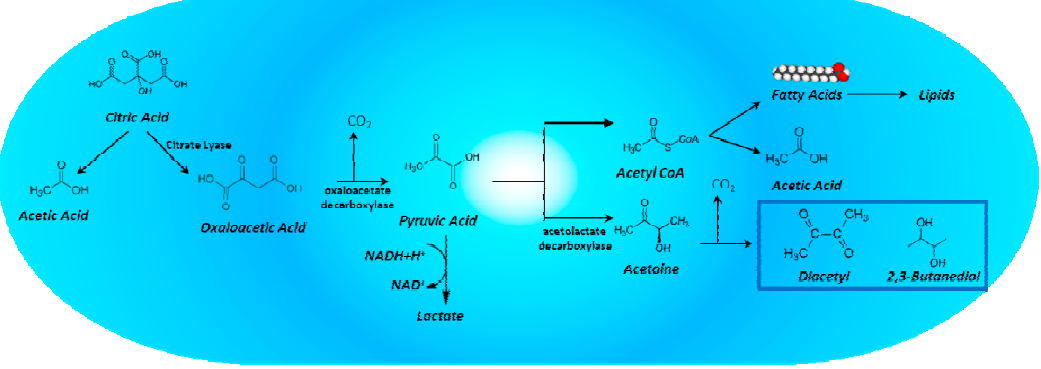
Figure 7. Schematic representation of citric acid degradation pathway by lactic acid bacteria .